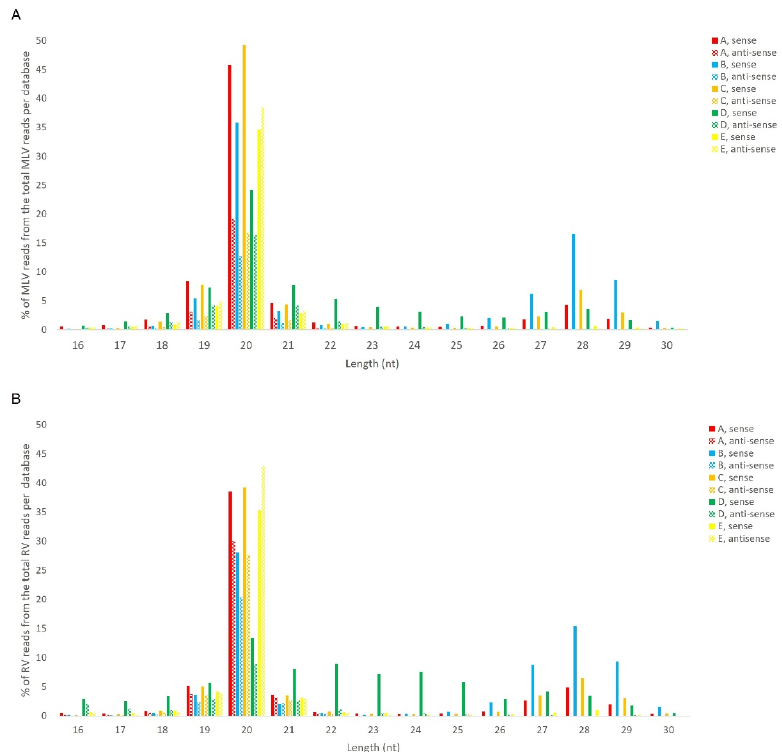
Figure 6. Length distribution of sRNAs, derived from BmN4 cells, mapping to B. mori Macula-like Latent Virus (MLV) ( A ) and S. frugiperda Rhabdovirus (RV) ( B ). The Y -axis represents the percentage of viral reads for each length, in the total of the 16–30 nt viral reads. The X -axis represents the length of the reads in nucleotides. Solid bars: sense reads. Dotted bars: anti-sense reads. A–E: represented databases, listed in Table S2.